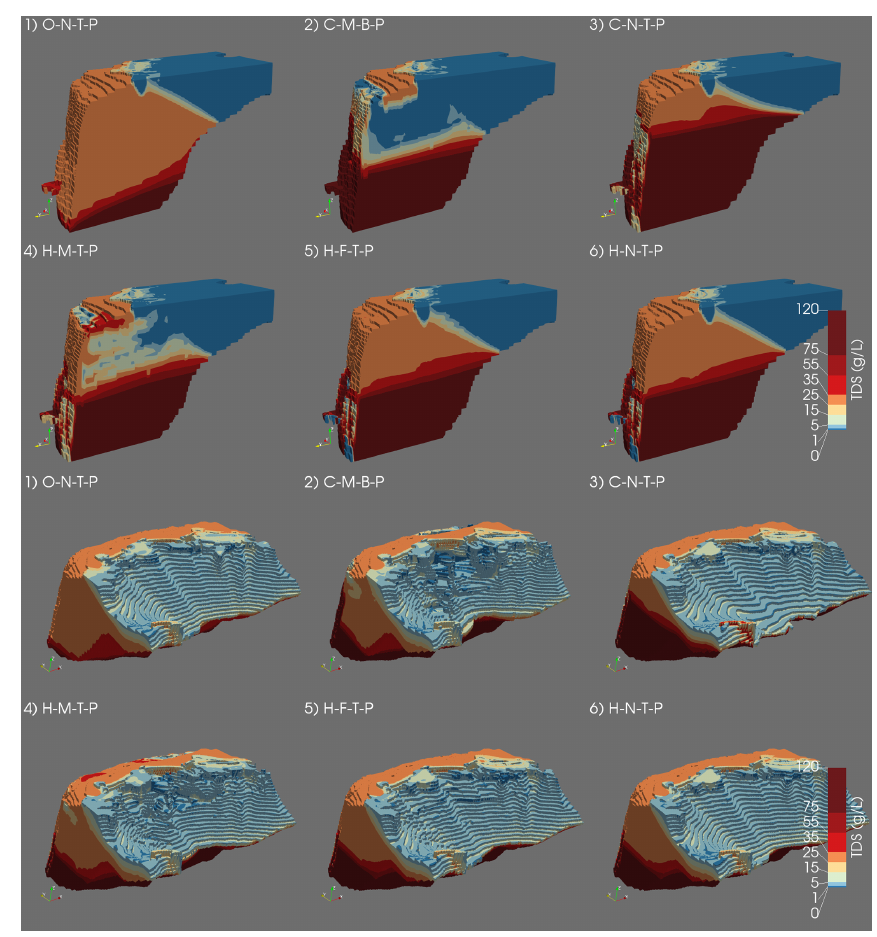
Figure 4. Salinity distributions of the five selected model scenarios after the validation; the results of the homogeneous model (viz. O-N-T-P) are also added as a first plot for reference. Note that the results are stretched in the z direction by a factor 150. In the top six plots the salinity distribution is sliced in half over the model domain and the camera is pointed in the south-easterly direction. In the bottom six plots the full delta is visible, but the fresh groundwater is made fully transparent. The camera is pointed downwards in the north-easterly direction.